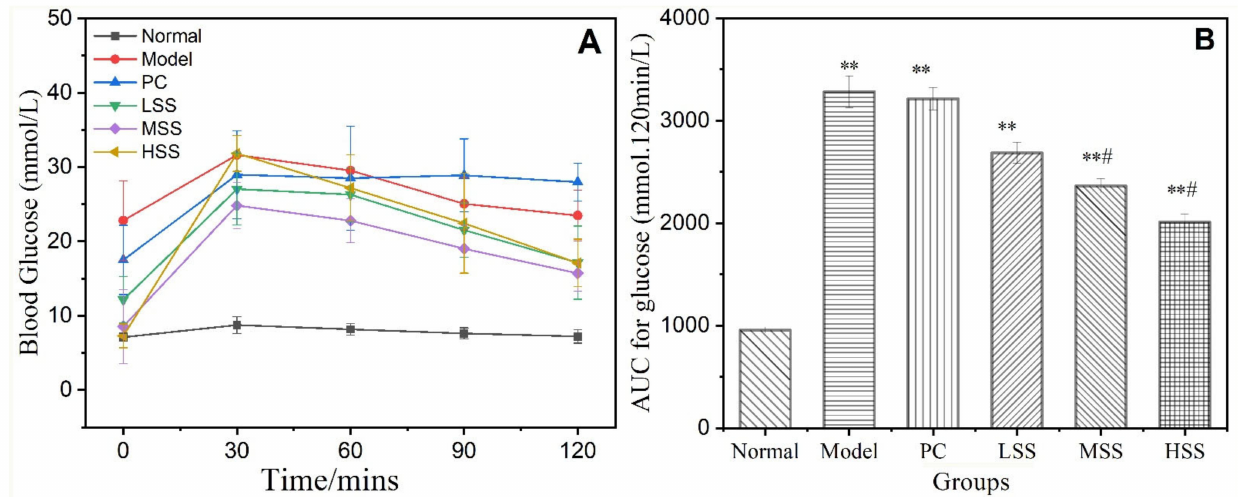
Figure 2. Effects of oral SS administration on the OGTT results of T2D rats. ( A ) Blood glucose; ( B ) AUC for blood glucose. Normal: normal group; Model: diabetic model group; PC: 0.5% metformin administration; LSS, MSS, and HSS: 1, 2.5, and 5% SS administration, respectively. n = 3, ** p < 0.01, vs. normal group; # p < 0.05, vs. model